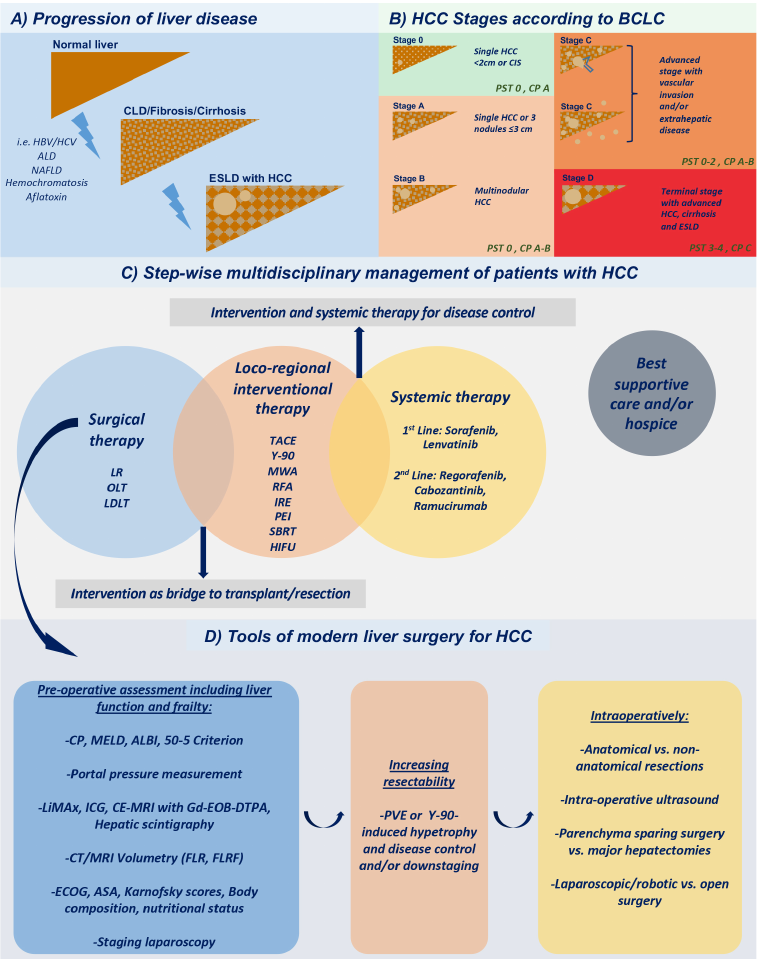
Figure 1. Multidisciplinary HCC evaluation and treatment. ( A ) Progression of liver disease; ( B ) HCC stages according to BCLC; ( C ) Step-wise multidisciplinary management of patients with HCC; ( D ) Tools of modern liver surgery for